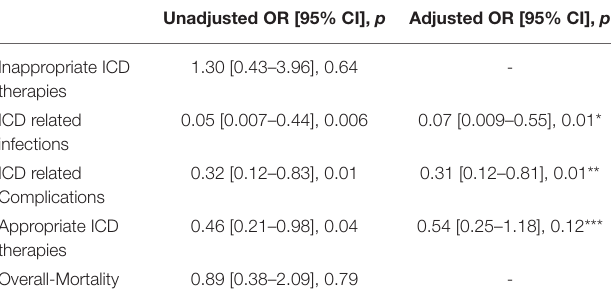
TABLE 5 | Unadjusted and adjusted odds ratio for S-ICD and the clinical outcomes of